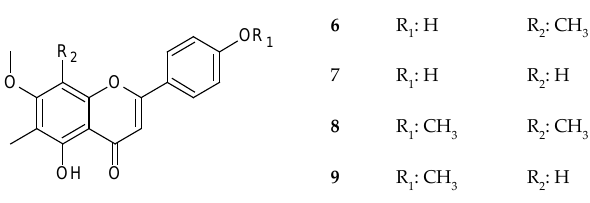
Figure 1. Structures of isolated compounds.